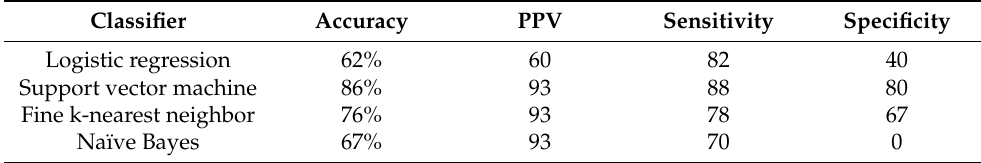
Table 3. Classifiers’ comparison based on 5-fold cross-validation.